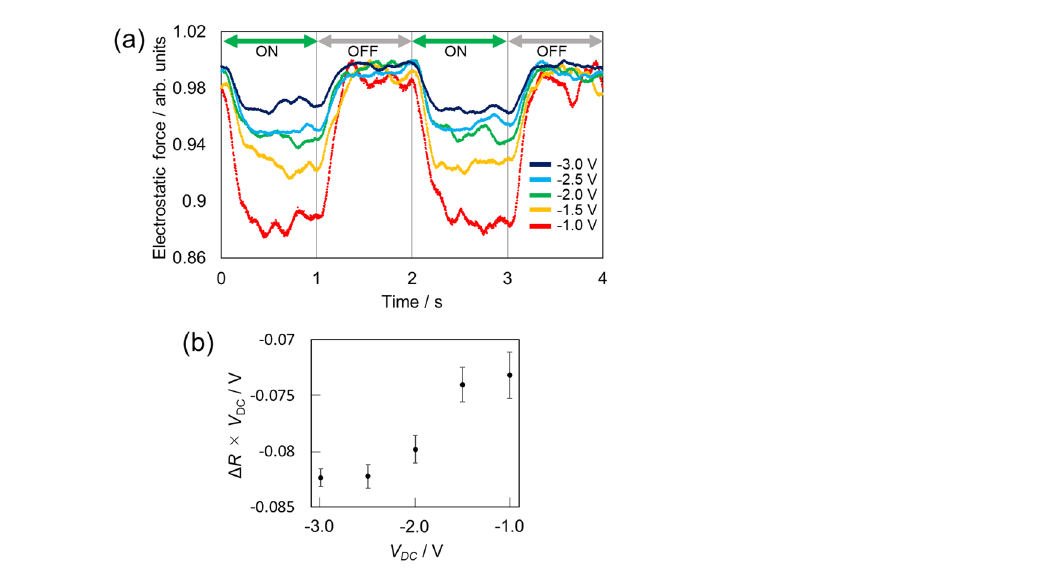
Figure 3. ( a ) Time evolution of the EF on Au NPs at different V DC normalized by the EF value just before the laser was switched on. The switching interval of the laser irradiation is shown by the double arrows. The data of time evolution of EF was integrated over 25 sets of the switching unit, which is composed of two ON → OFF cycles. ( b ) Plot of Δ R × V DC vs. V DC . Δ R × V DC corresponds to Δ CPD in the steady state. The error bars show the 2σ standard